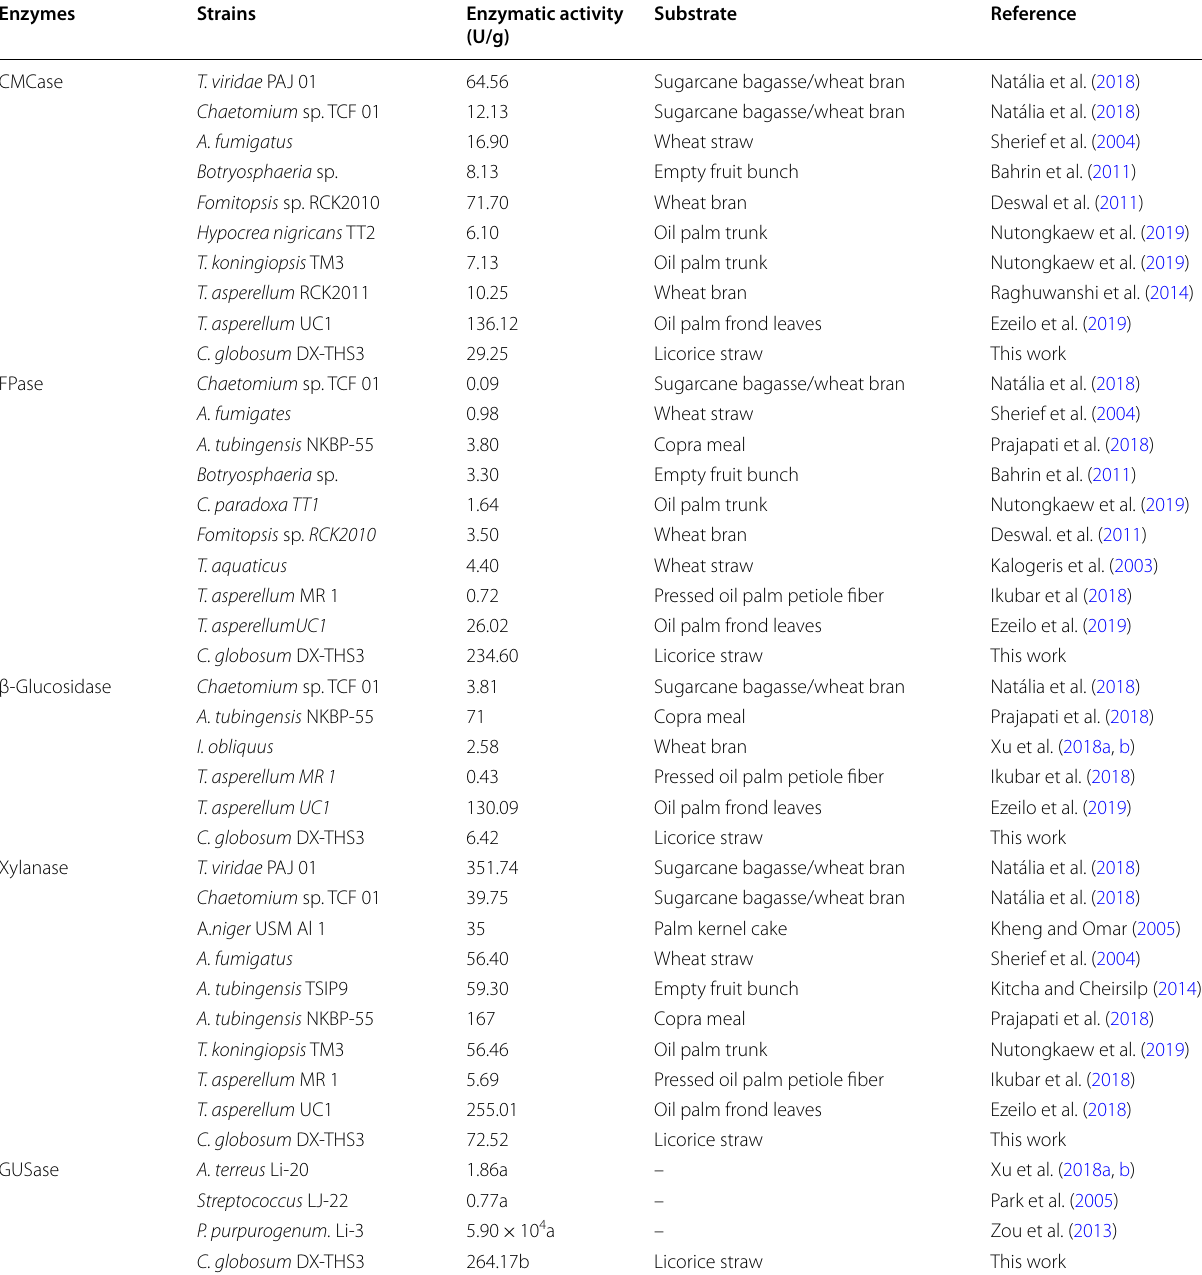
Table 2 Comparison of CMCase, FPase, β-glucosidase, xylanase, and GUS activities by C. globosum DX-THS3 and other fungi under